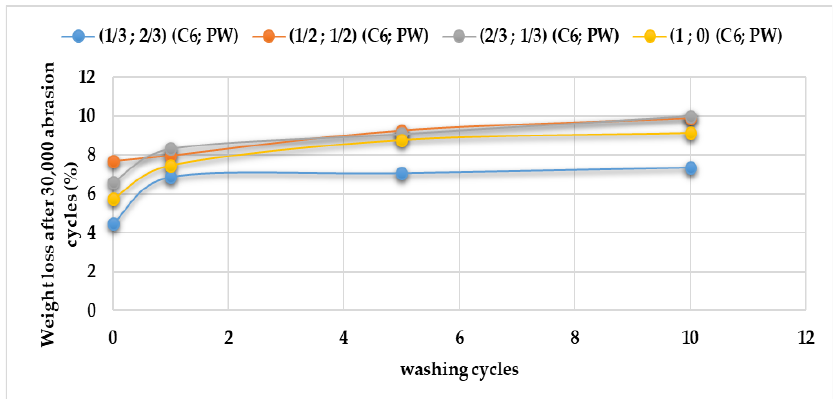
Figure 12. Mass loss rate fabric, treated with (1/2; 1/2) (PU;PX) for the first padding and then with the four different polymer blend combinations (C6; PW), measured after zero, one, five, and ten washes with 30,000 abrasion cycles for each. Table 7. Area shrinkage and flexural rigidity results of the samples first treated with (1/2; 1/2) (PU; PX) and then with different combinations of the second padding bath